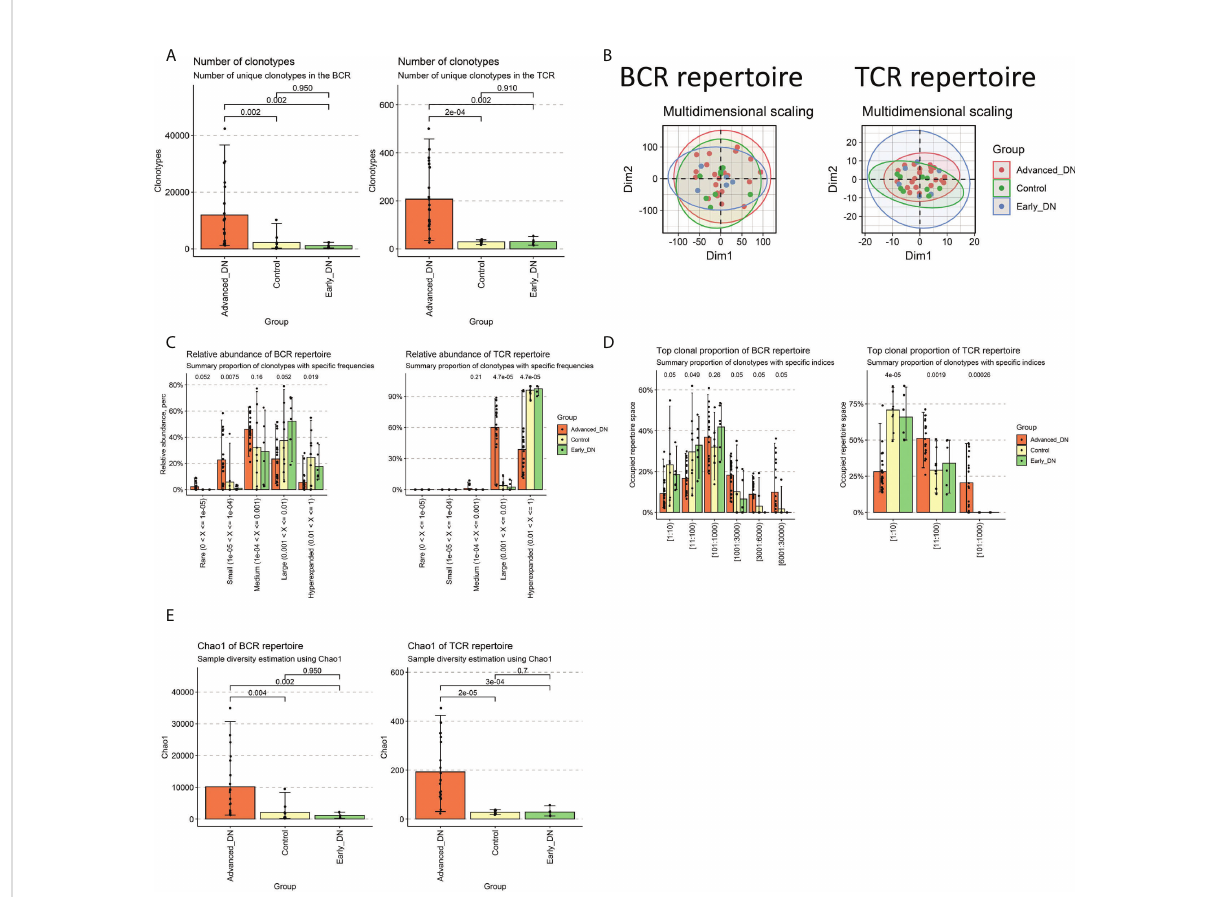
FIGURE 1 Characteristics of DN immune repertoire (BCR repertoire and TCR repertoire). (A) Comparison of clonotype numbers for BCR repertoire and TCR repertoire. The clonotypes here are de fi ned according to the nucleotide sequence of CDR3. Each CDR3 sequence de fi nes a unique clonal population. (B) Immune repertoire overlapping clustering. Clonal contigs of BCR repertoire and TCR repertoire were clustered separately. The number of public clonotypes is used to calculate the overlap similarity between samples (.method= “ public ” of the immunarch